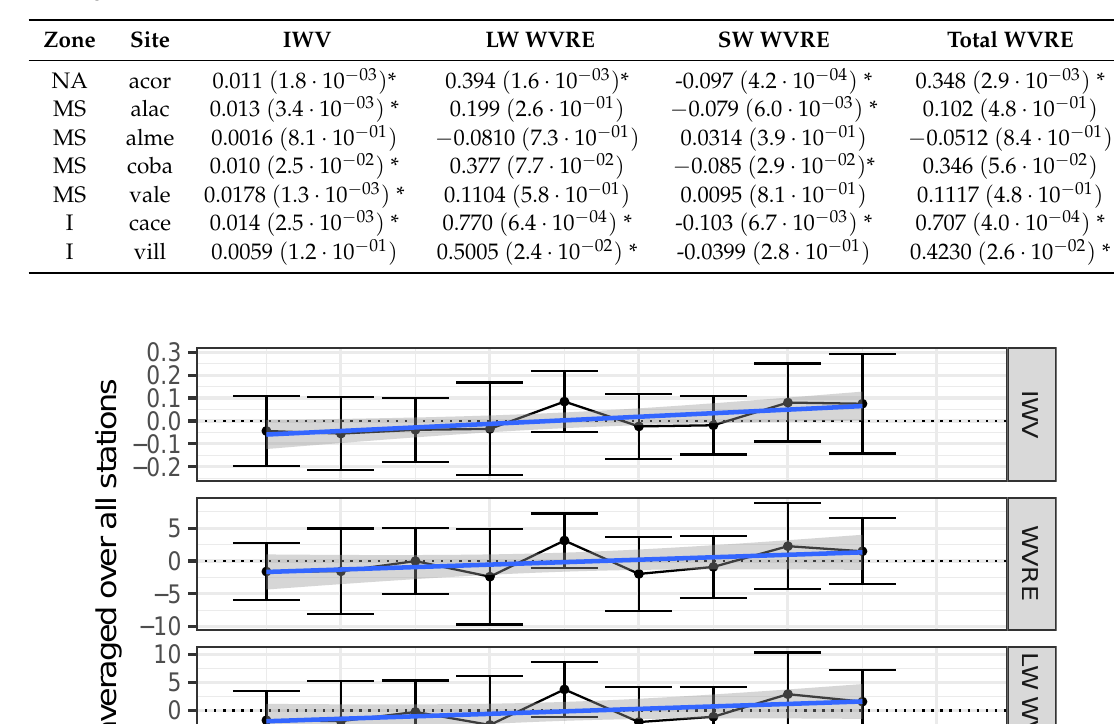
Table 4. Trends of IWV and WVRE (total, LW and SW). Values are in cm year − 1 for IWV and Wm − 2 year − 1 . P-values are shown in parenthesis, and an asterisk (*) is added to statistically significant results.